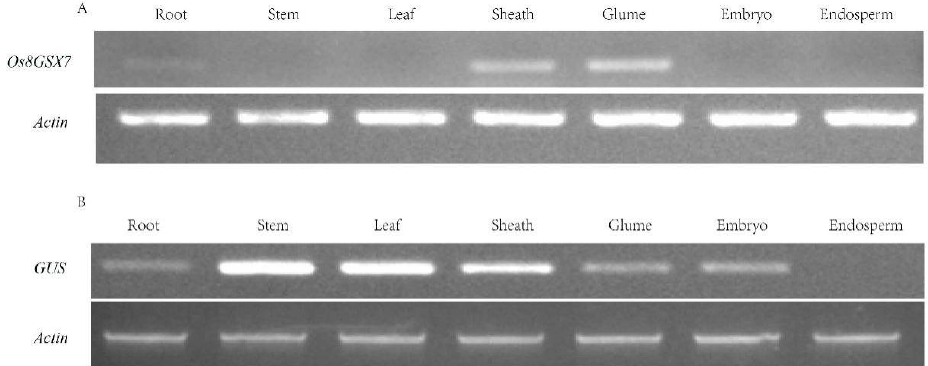
Figure 3. Expression profiles of Os8GSX7 and GUS by RT-PCR analysis. ( A ) Expression profiles of Os8GSX7 gene by RT-PCR analysis in the wild type; ( B ) Expression profiles of GUS gene in transgenic positive lines of GSX7R-2097 by RT-PCR analysis. The rice Actin gene was used as an internal control.